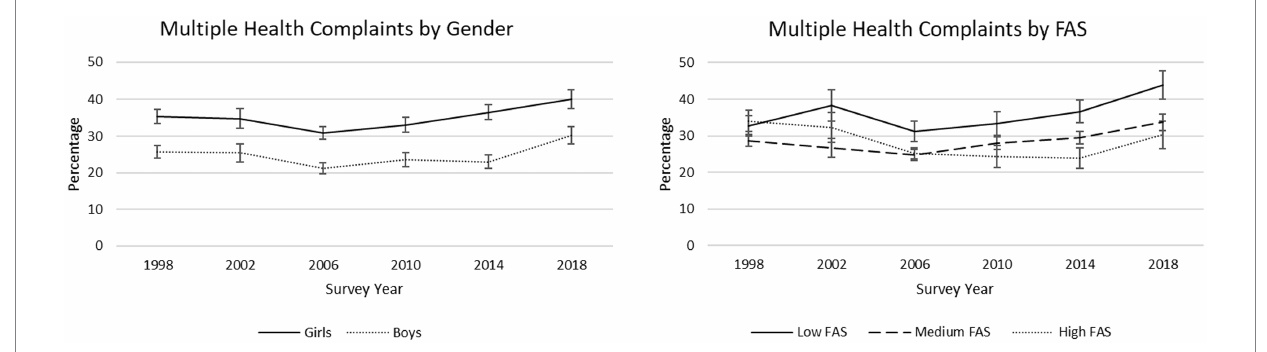
FIGURE 1 Trends in percentages of reported multiple health complaints (i.e., at least two of eight weekly symptoms), by gender and by Family Affluence Scale (FAS). 95% confidence intervals are depicted.